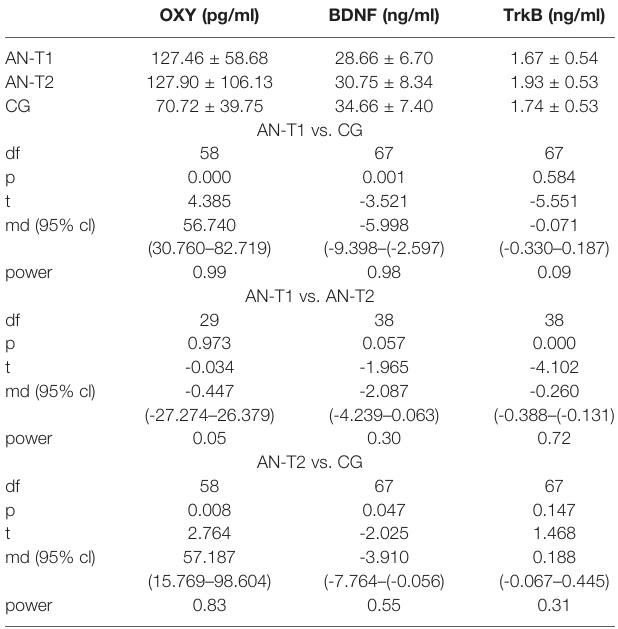
levels of OXY in AN patients below 18 years old, though the highest incidence rate subgroup for AN includes girls aged 15 – 19 years old and accounts for about 40% of all identi fi ed cases. Results from studies conducted in adult AN patients are con fl icting. In one study, no differences in basal OXY levels between AN and control groups were demonstrated (44).